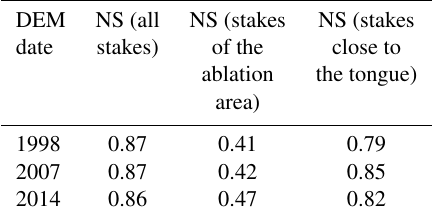
Table 2. NS efficiency coefficient for simulated summer mass bal- ances with respect to measured values over the 2006–2010 period using different 200m resolution DEMs. The evaluation was per- formed using all stake measurements, only stakes located in the ab- lation area and stakes located in the tongue of the glacier where geometry changes are